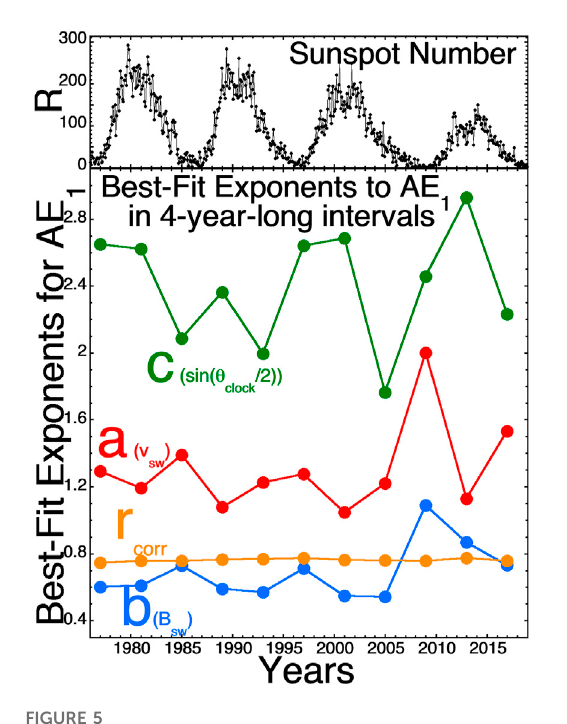
FIGURE 5 (top panel) For the years 1995 – 2008 the 27-days-averaged sunspotnumberisplotted.(bottompanel)Thebest- fi t (A) (red), (B) (blue),and (C) (green)exponentsforAE 1 arecalculatedinfour-year blocks of OMNI2 solar-wind data from 1995 – 2018. For each four-year data block the Pearson linear correlation coef fi cient between D and AE 1 is plotted in